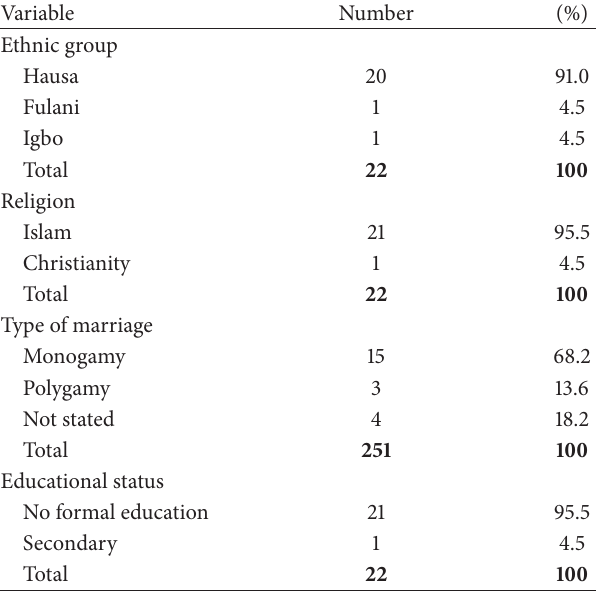
Table 2: Sociodemographic characteristics of the